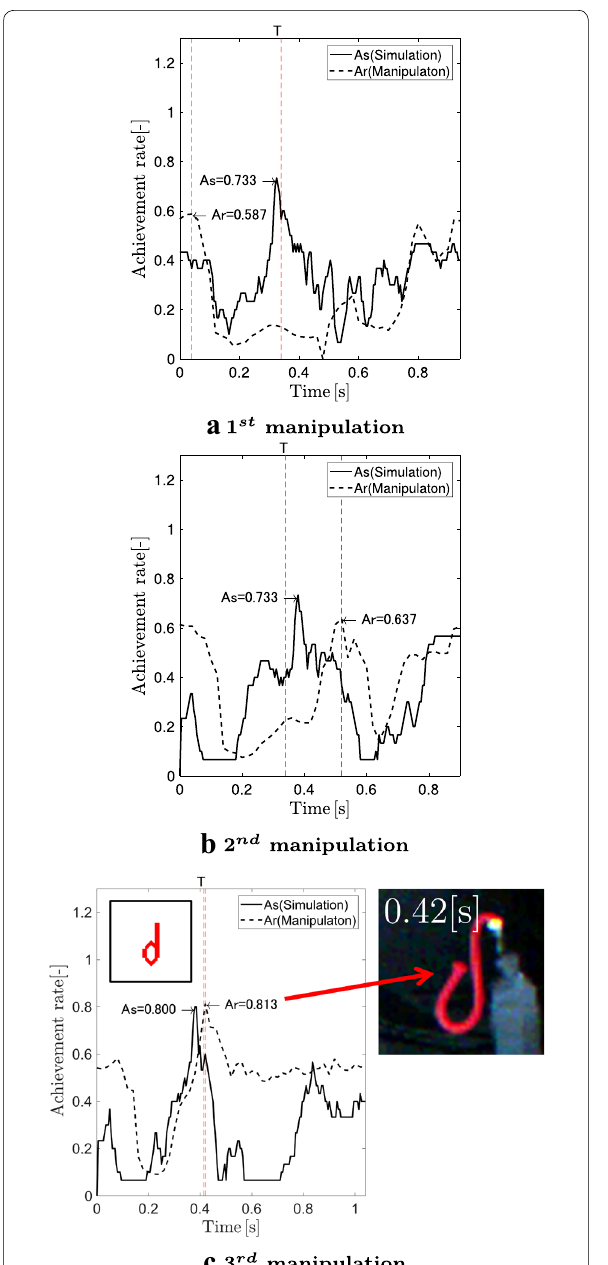
Fig. 11 Experimental result of achievement A r , A s (desired image of string shape:d)